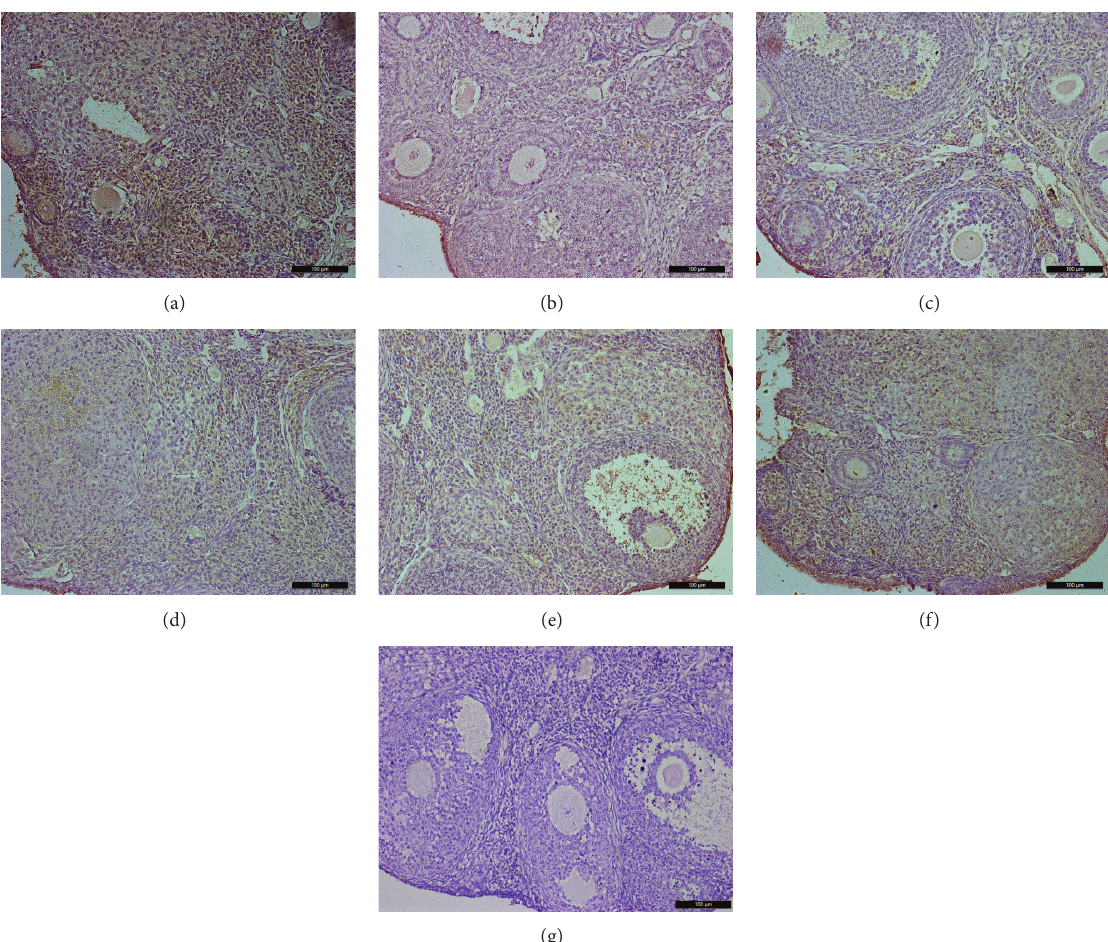
Figure 6: Immunohistochemical analysis for VEGFR1 expression in mice ovaries of different groups 2 weeks after treatment; ovarian sections with no primary antibody were served as negative controls. (a) control group; (b) Bu/Cy-treated group; (c) Bu/Cy + hAECs (24 h) group; (d) Bu/Cy + hAECs-CM (24h) group; (e) Bu/Cy + hAECs (7 d) group; (f) Bu/Cy + hAECs-CM (7 d) group; (g) negative control. Scale bar: 100 𝜇